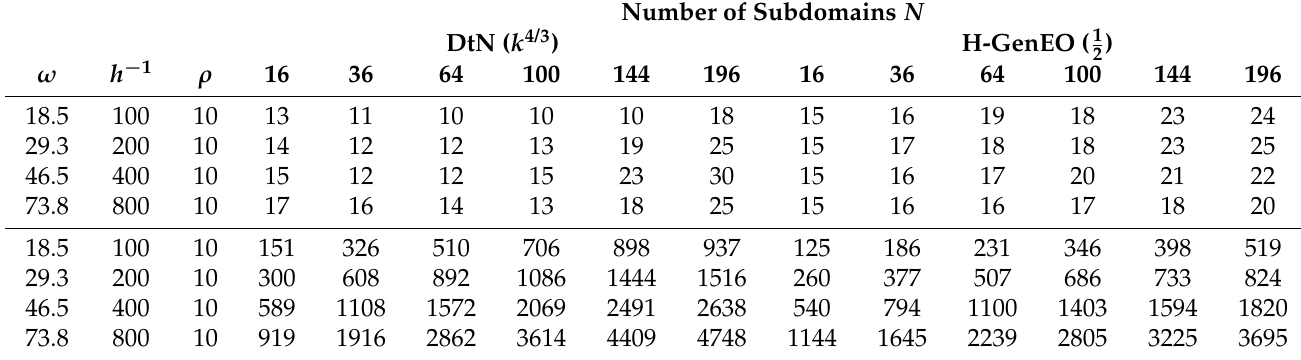
Table 8. Preconditioned GMRES iteration counts (above) and size of coarse space (below) for P2 finite element discretisation of the heterogeneous diagonal layers problem with ρ = 10 when using ORAS with DtN( k 4/3 ) or H-GenEO( 1 ) and a varying number of subdomains. A uniform decomposition √ √ 2 N × N square subdomains is used. into